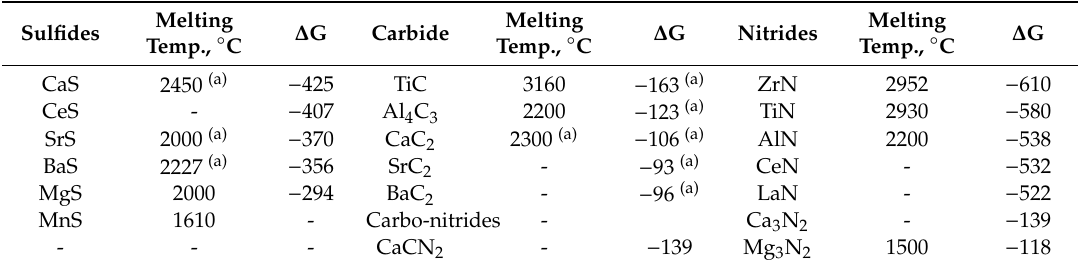
Table 3. Melting points and standard free energy (kJ / mol) of formation of selected sulfides, carbides and nitrides [85].